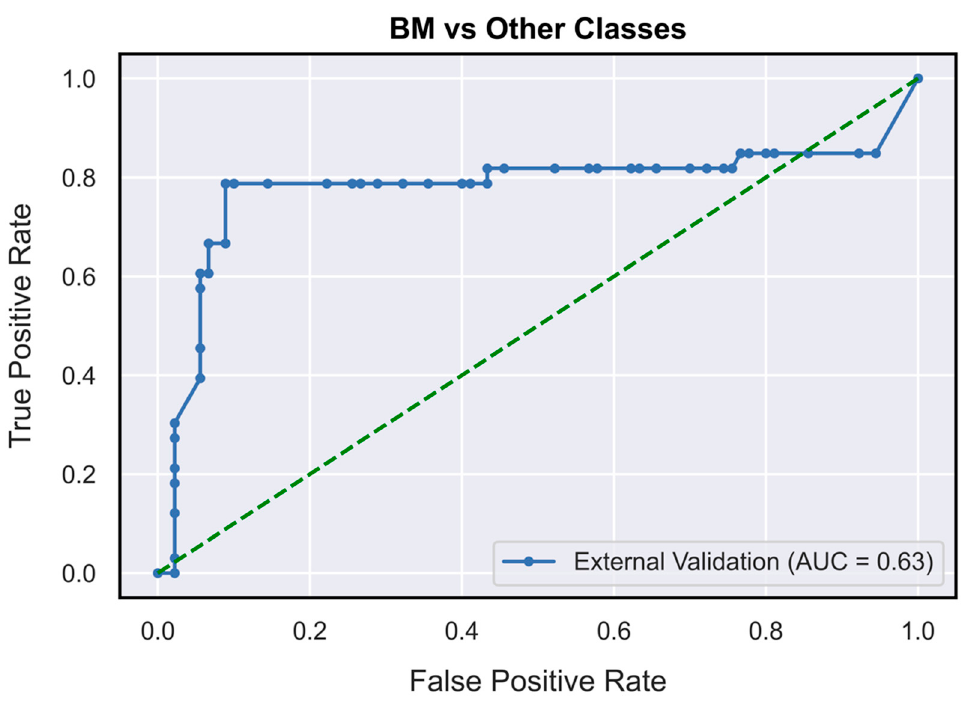
Figure 4. AUC-ROC curves (on TeS validation dataset) for solitary brain metastasis diagnostic outcome class (OVR). BM: brain metastasis; OVR: one-vs-rest. Table 2. Performance metrics achieved by the convolutional neural network model in differentiating PCNSLs, glioblastomas and